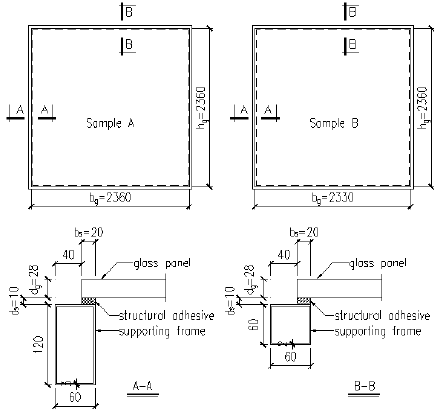
Figure 1. Dimensions of panel units.